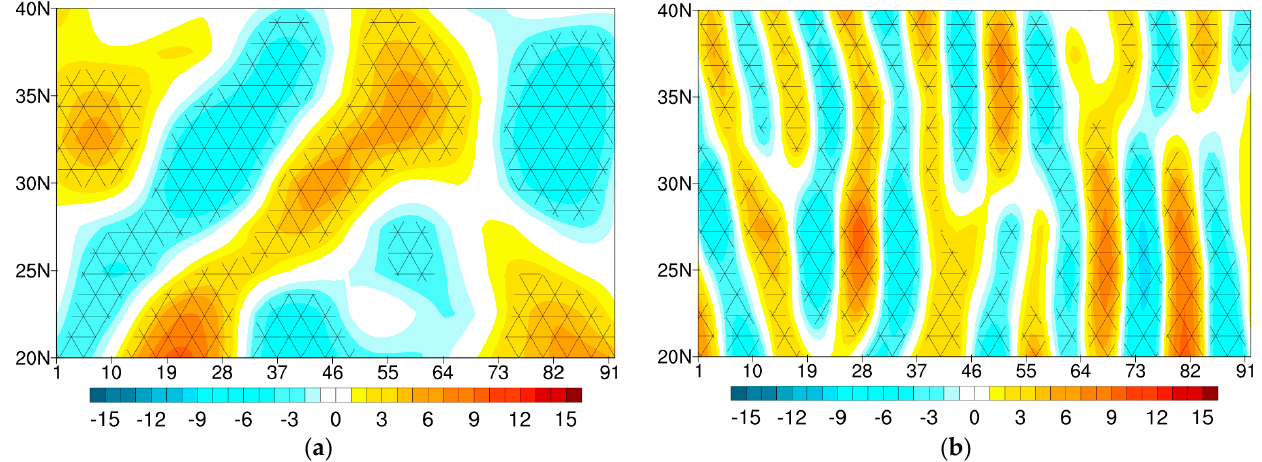
Figure 8. Time-longitude profile of OLR along 105° to 130° E ( a ) strong monsoon surge years ( b ) weak monsoon surge years.